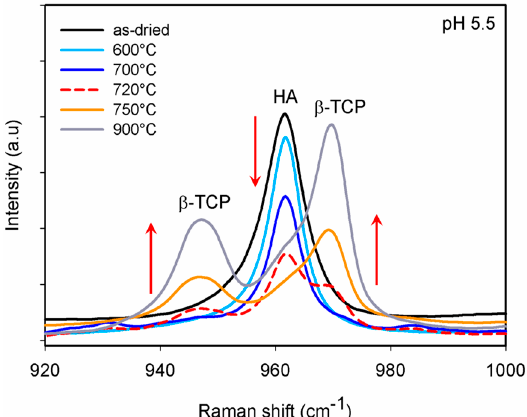
Figure 6. Raman spectra of the samples that were synthesized at pH 5.5. The effect of sintering temperature on the chemical transformation of CDHA to β -TCP is revealed by tracking the most characteristic ν 1 mode. Transformation to β -TCP is started at 720 °C and is almost complete as early as 750 °C.